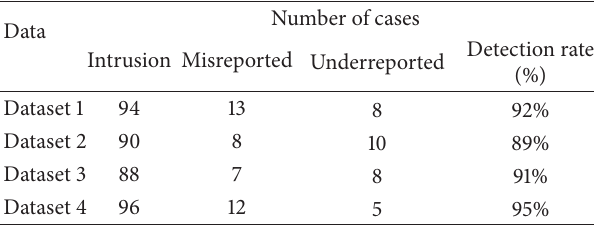
Table 3: Statistics based on information collected.